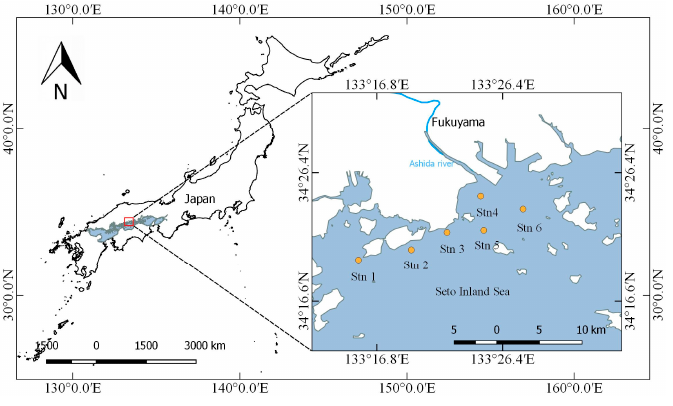
Figure 1. Research site locations in this study. Table 1. Stations for data collection in the study.